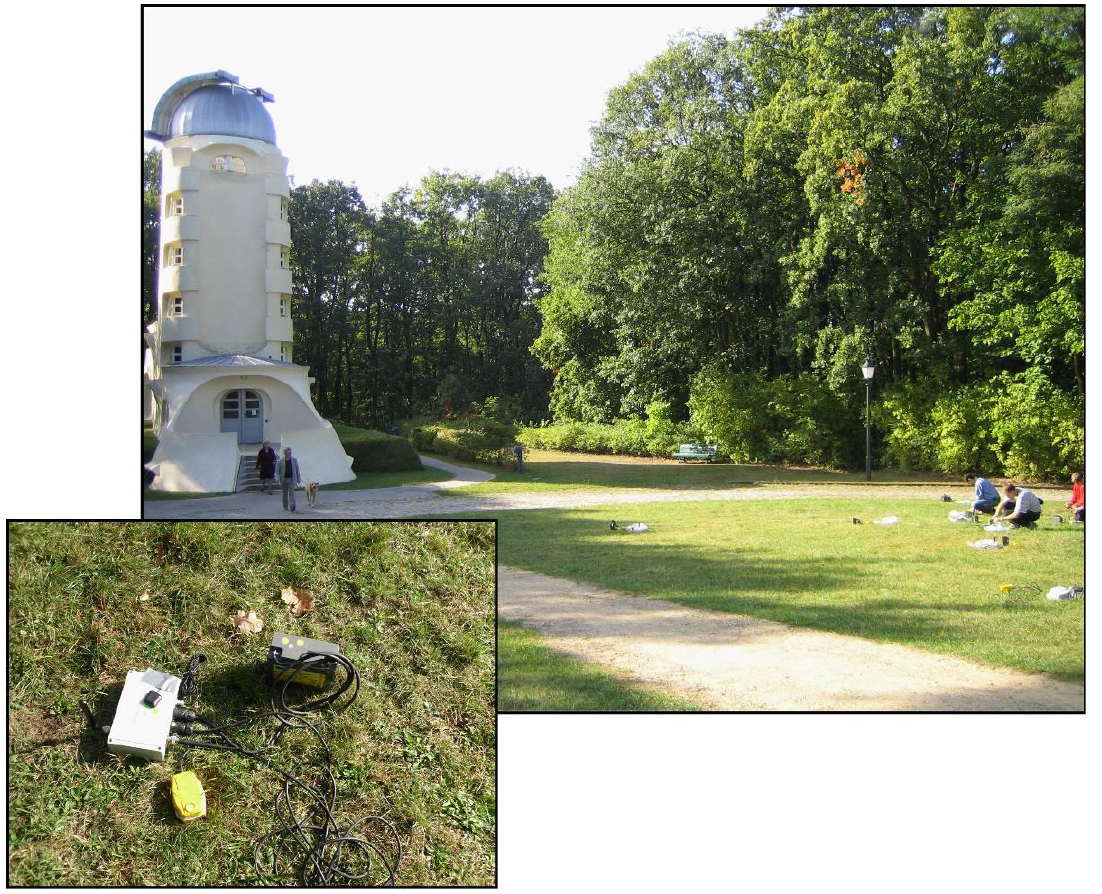
Figure 5. Field test with the GFZ-WISE system at the Alfred Einstein Science Park in Potsdam, Germany. In the inner inset it is shown an example of GFZ-WSU